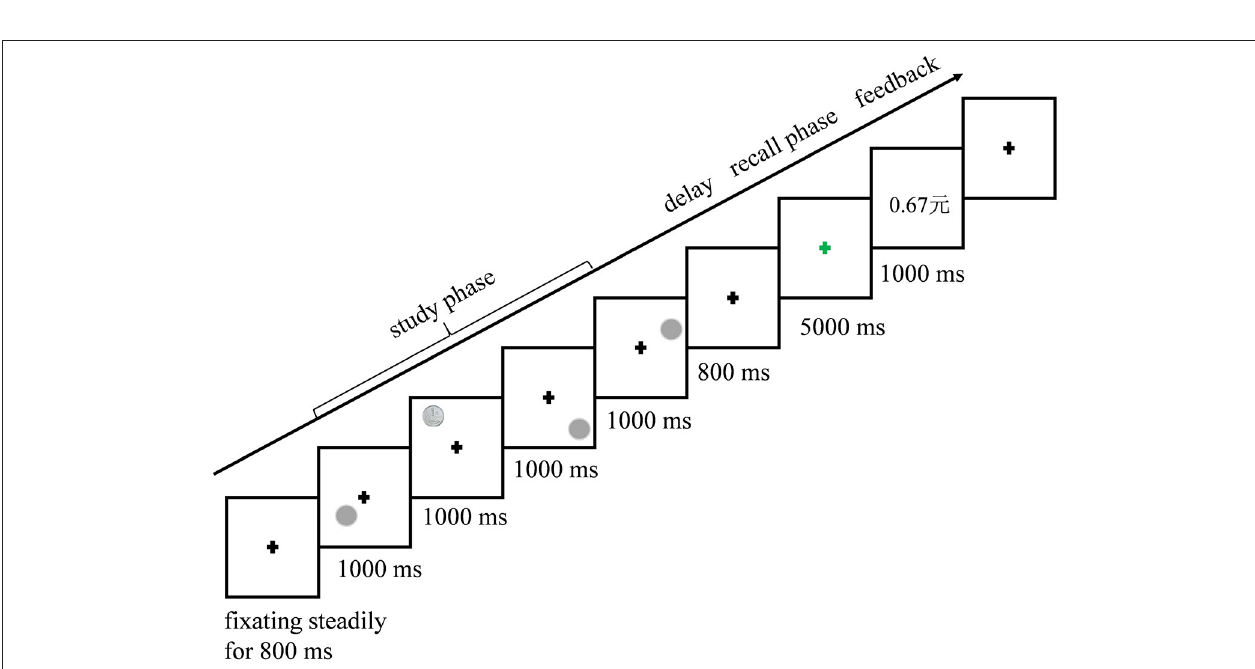
FIGURE 2 | An example of the sequence of events and presentation times.